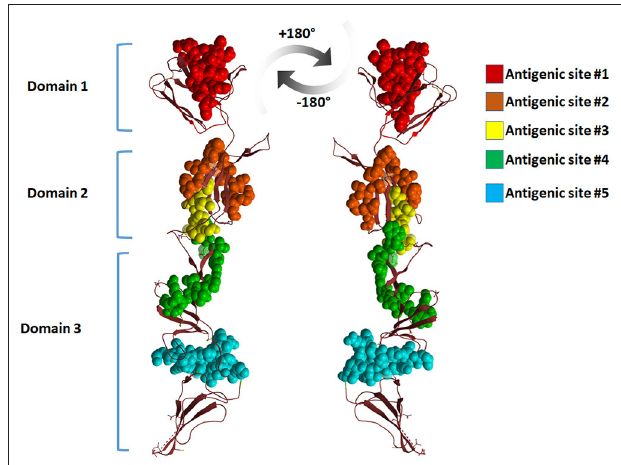
FIGURE 5 | Cartoon representation of BVDV-E2 glycoprotein monomer showing the antigenic sites predicted by EMBOSS antigenic prediction tool. The top five antigenic sites were given in spheres with different colors. The figure was derived from the structure deposited in the protein data bank (PDB ID